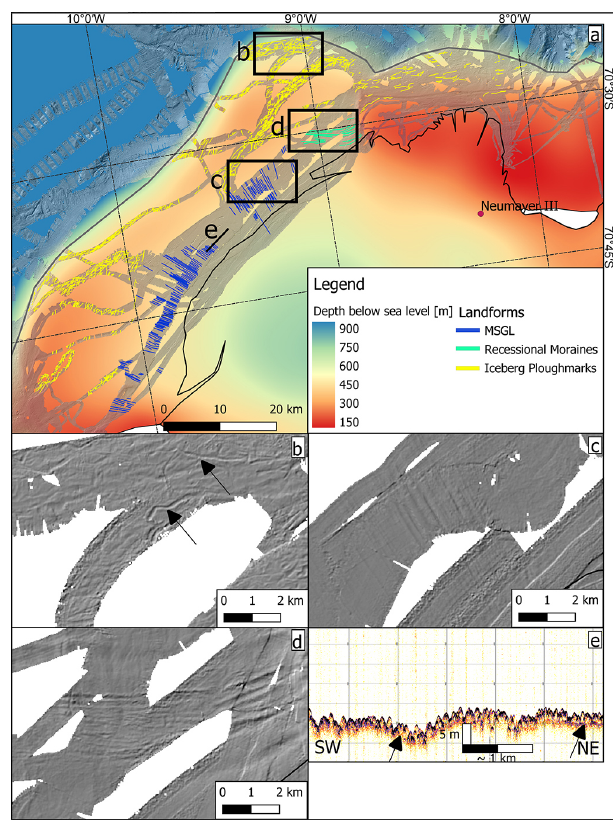
Figure 3. Landforms at the continental shelf. The panel (a) displays the water depth and an overview of the identified landforms. The rectangles in the bathymetry map (a) indicate the location of the close-ups of iceberg ploughmarks (b) , MSGLs (c) and recessional moraines (d) . Their orientation is the same as in panel (a) . Panel (e) is an echogram of the MSGL: the left black arrow indicates the absence of a basal layer and the right arrow its